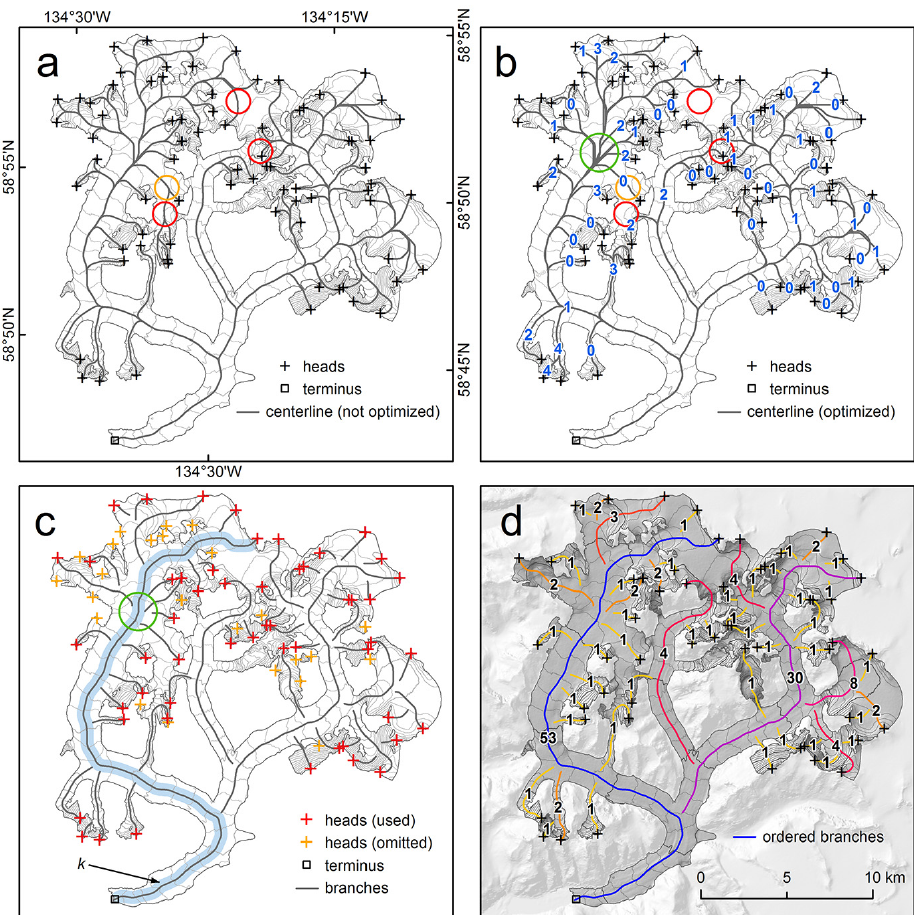
Fig. 8. The main processing steps using the example of Gilkey Glacier, Juneau Icefield. (a) The grey lines show the centerlines derived without the optimization, using a = 4 . 25 and b = 3 . 5 (Eq. 2). Red and orange circles mark implausible centerlines. (b) Centerlines after the optimization. The lines indicated by red circles are improved, while the line indicated by the orange circle remains unchanged. Blue bold numbers show the final iterative solutions for selected centerlines (e.g., “3” means solution of iteration three) given a 1b increase of 0.1 per iteration. The green circle marks an area of imperfect overlap after optimization of the centerlines, which is due to the different applied b values. (c) Branches after splitting the centerlines. The width of the blue area illustrates k (Eq. 8). Overlapping parts (green circle) are eliminated and short segments (belonging to the orange heads) are omitted. (d) Branches after allocation of geometric order. The order number indicates the number of first-order branches flowing into the corresponding